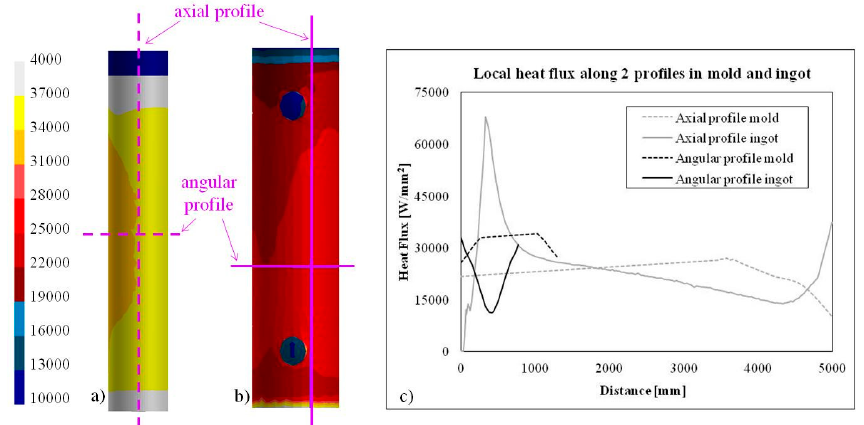
Figure 14. Heat flux along two profiles of the ingot ( a ) and mold ( b ); ( c ) Local heat flux as a function of the distance just after the stripping of the ingot.